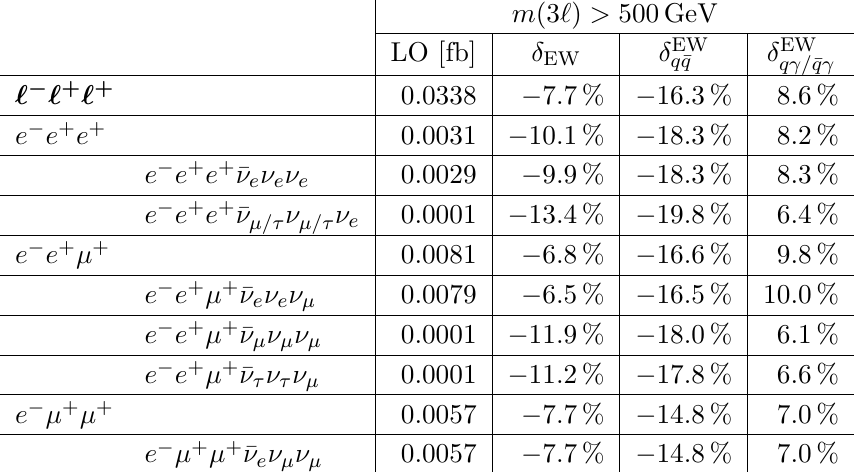
Table 5 . Cross section and electroweak corrections in the high trilepton invariant mass region de(cid:12)ned by adding the requirement m (3 ‘ ) > 500 GeV to the (cid:12)ducial cuts of table 3. The